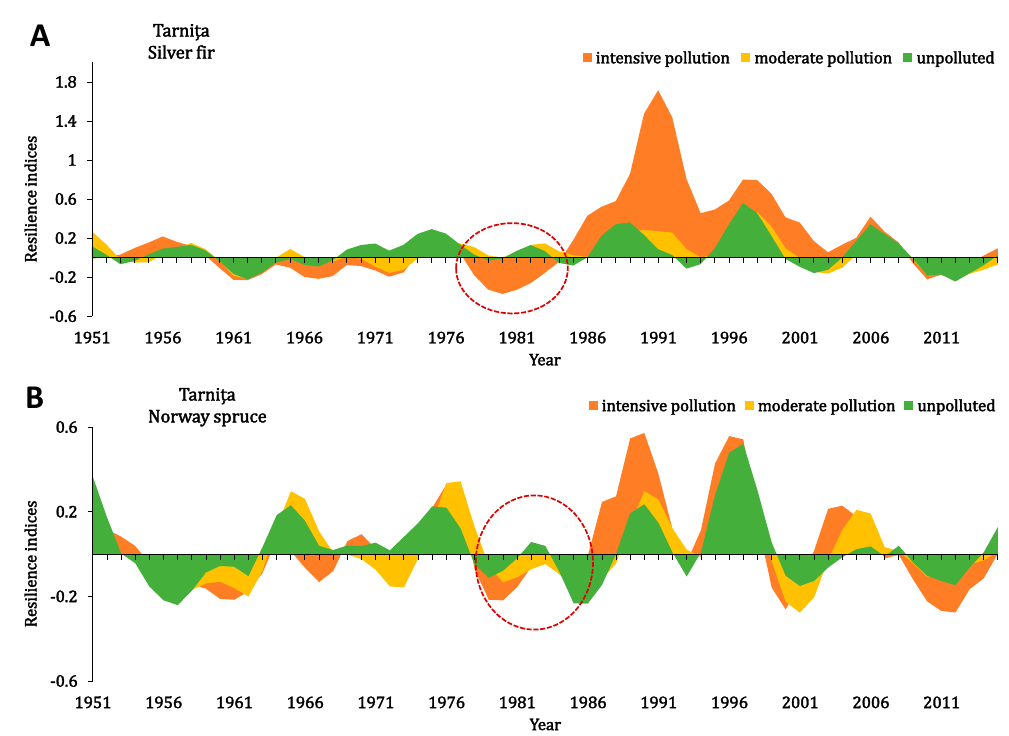
Figure 4. Average resilience indices for each of the 3 categories of silver fir ( A ) and Norway spruce ( B ) stands in the Tarni ț a Forests 2021 , 12 , x FOR PEER REVIEW area (the dotted circle represents the time interval in which the trees were most affected by the influence of pollution). The quantification of growth losses for silver fir reflects reductions of up to almost 20% (in 1984 and 1989) in heavily polluted areas (Figure 5A). The growth losses of trees located in moderately polluted areas were not as significant (up to 5%–7% relative to nor ‐ mal). The average losses throughout the highlighted period for heavily polluted silver fir were approximately 14%. Compared to the silver fir tree, the Norway spruce suffered much smaller diameter growth losses (Figure 5B). The average loss of diameter growth of the intensively polluted Norway spruce during the entire period of pollution exposure was 5%, and the loss was only 2% for the moderately polluted.